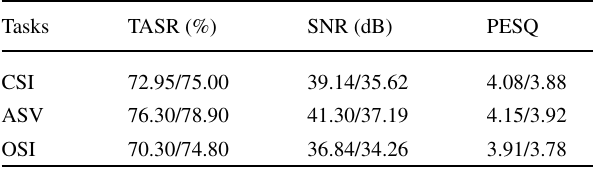
Table 9 The roles of regularization when conducting matched attacks on x-vector (with/without regularization) Tasks